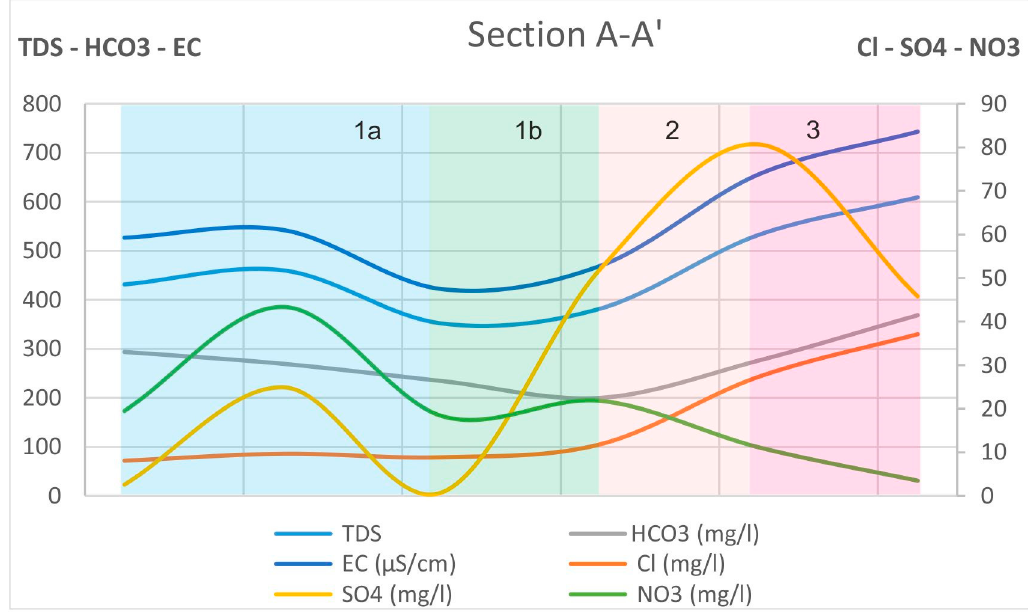
Figure 7. Variations in the concentration/values of major anions and physicochemical parameters along the groundwater flow.